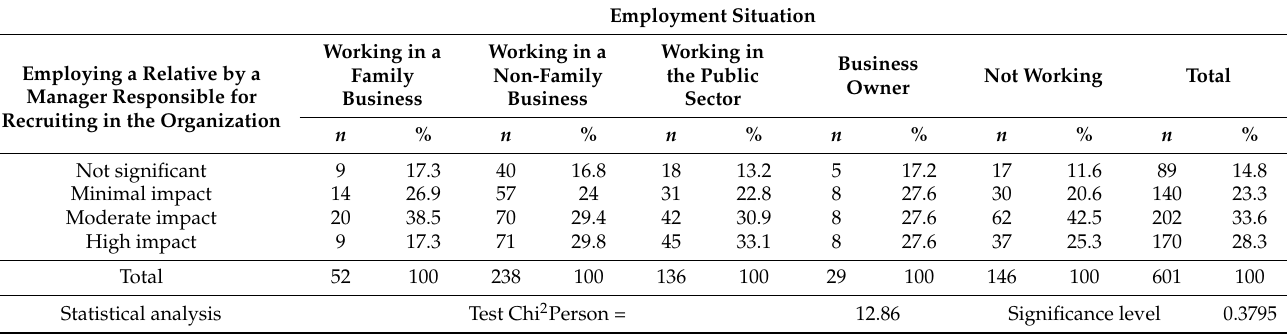
Table 6. Statistical analysis of the assessment of the impact of the Covid pandemic on employing a family member by the manager responsible for recruitment in the organization depending on the